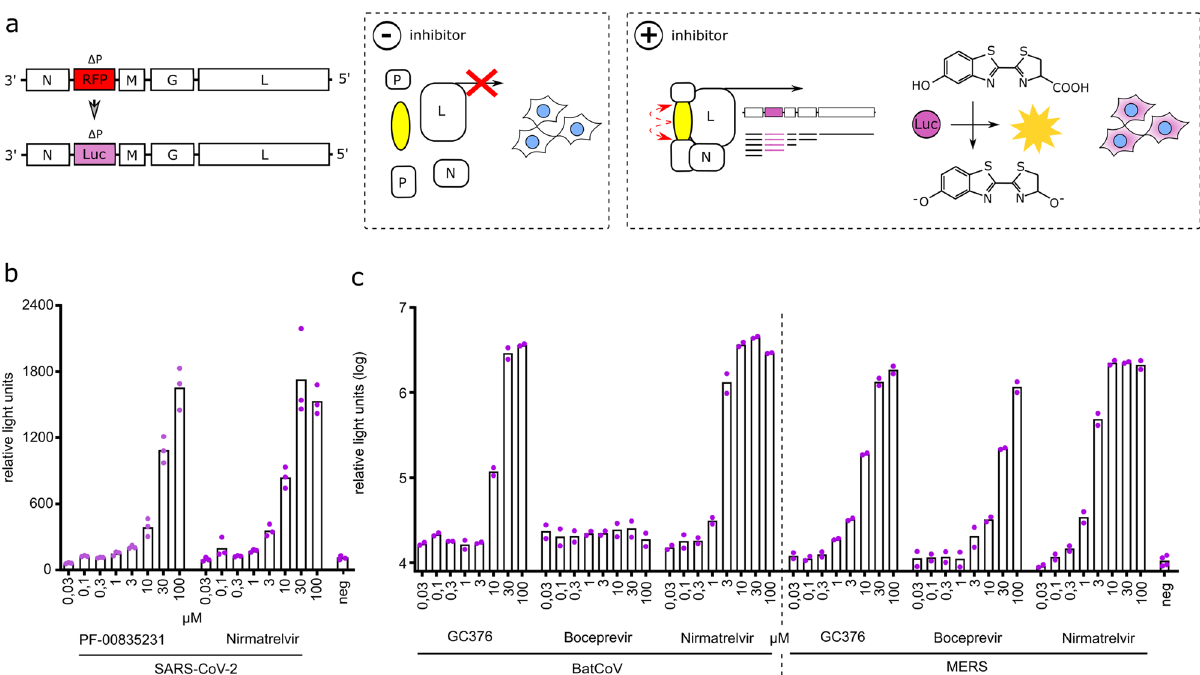
Fig. 5 Adaptation of inhibition-on assay to bioluminescence. a The red fl uorescent protein (RFP) dsRed in VSV- Δ P was replaced with fi re fl y luciferase, generating VSV- Δ P-Luc. Similar to the previous inhibition-on assay, addition of an inhibitor facilitates viral replication and gene expression. (dashed boxes separate schematics of molecular mechanism occurring in untreated ( − protease inhibitor) versus treated ( + protease inhibitor) cells). b 293T cells were transiently transfected with the SARS-CoV-2 inhibition-on plasmid and treated with either PF-00835231 or PF-07321332/nirmatrelvir and VSV- Δ P-Luc. ( n = 3 biologically independent replicates per condition with average values represented by histogram bars; negative control (neg) = average of transfected cells of each construct without inhibitor). c BHK21 stably transduced with bat coronavirus HKU9 (BatCoV) and MERS main proteases were tested with GC376, boceprevir, and PF-07321332/nirmatrelvir. ( n = 2 biologically independent replicates per condition with average values represented by histogram bars; negative control (neg) = average of transfected cells of each construct without inhibitor; dashed lines separate differently transduced